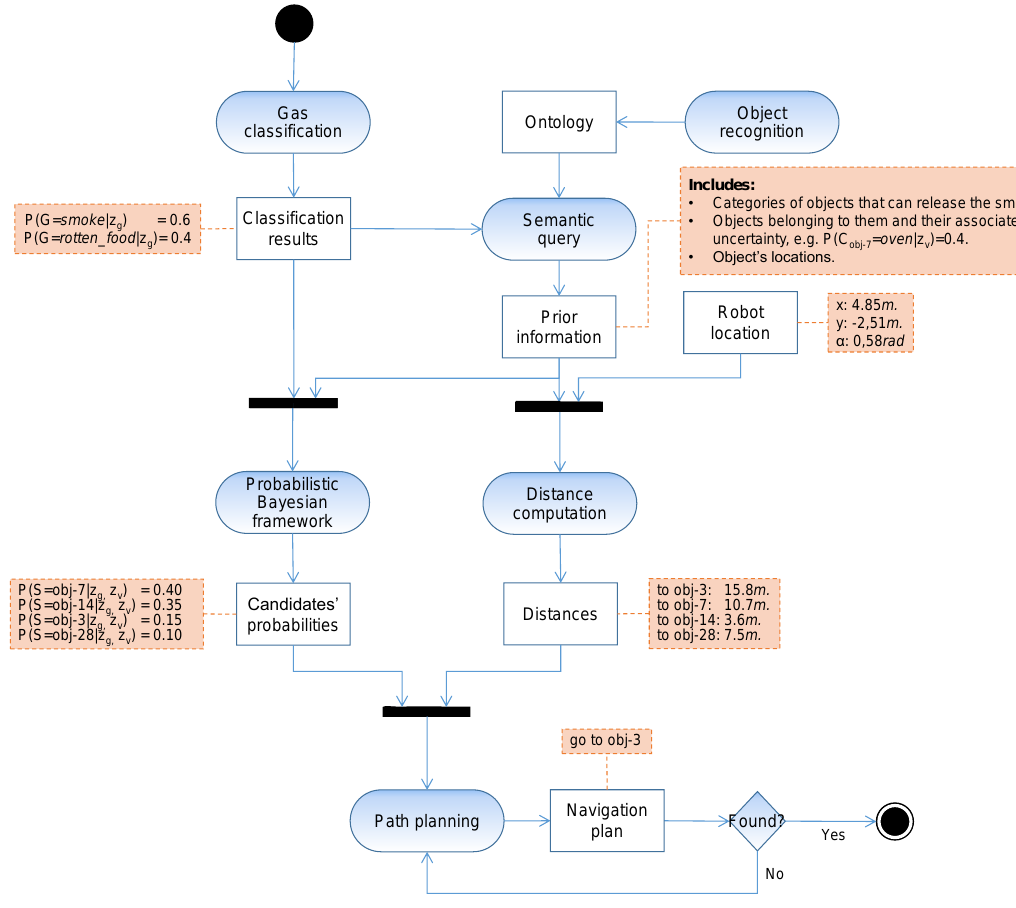
Figure 1. Activity graph (employing the unified modeling language (UML)) defining the workflow of the proposed system for semantic gas source